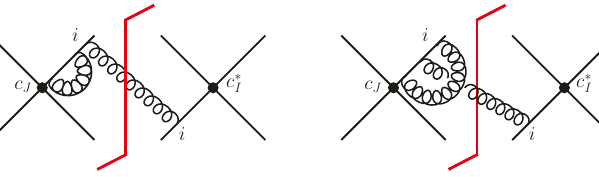
Figure 5 . One-Wilson-line virtual-real diagrams contributing to the NNLO soft function.